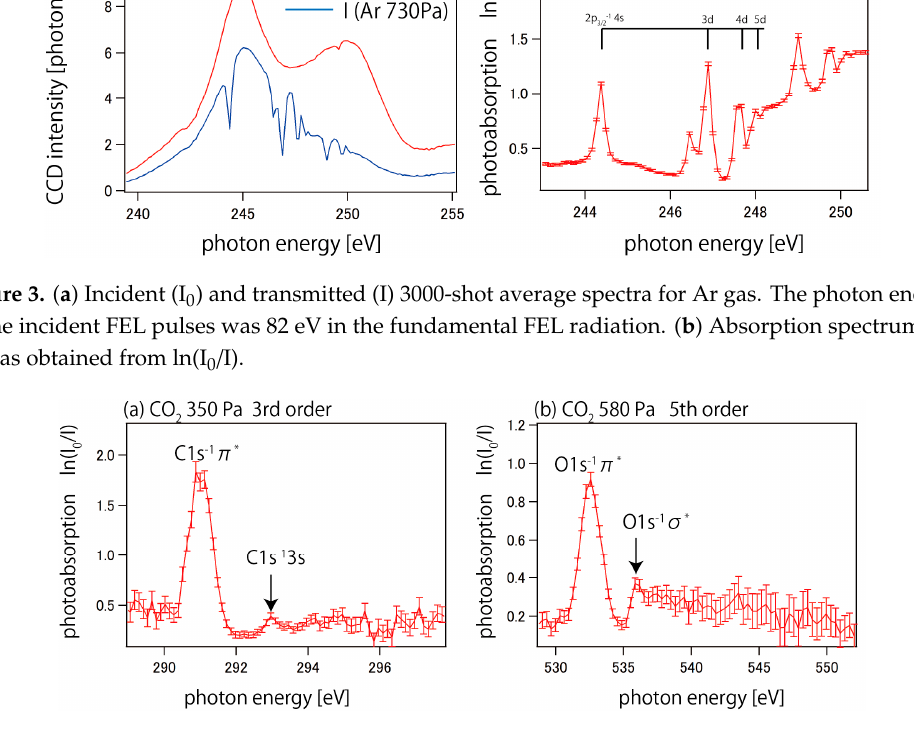
Figure 4. Soft X-ray absorption spectra for CO 2 gas around the ( a ) C 1s and ( b ) O 1s core ionization Table 98 and 108 eV, respectively.